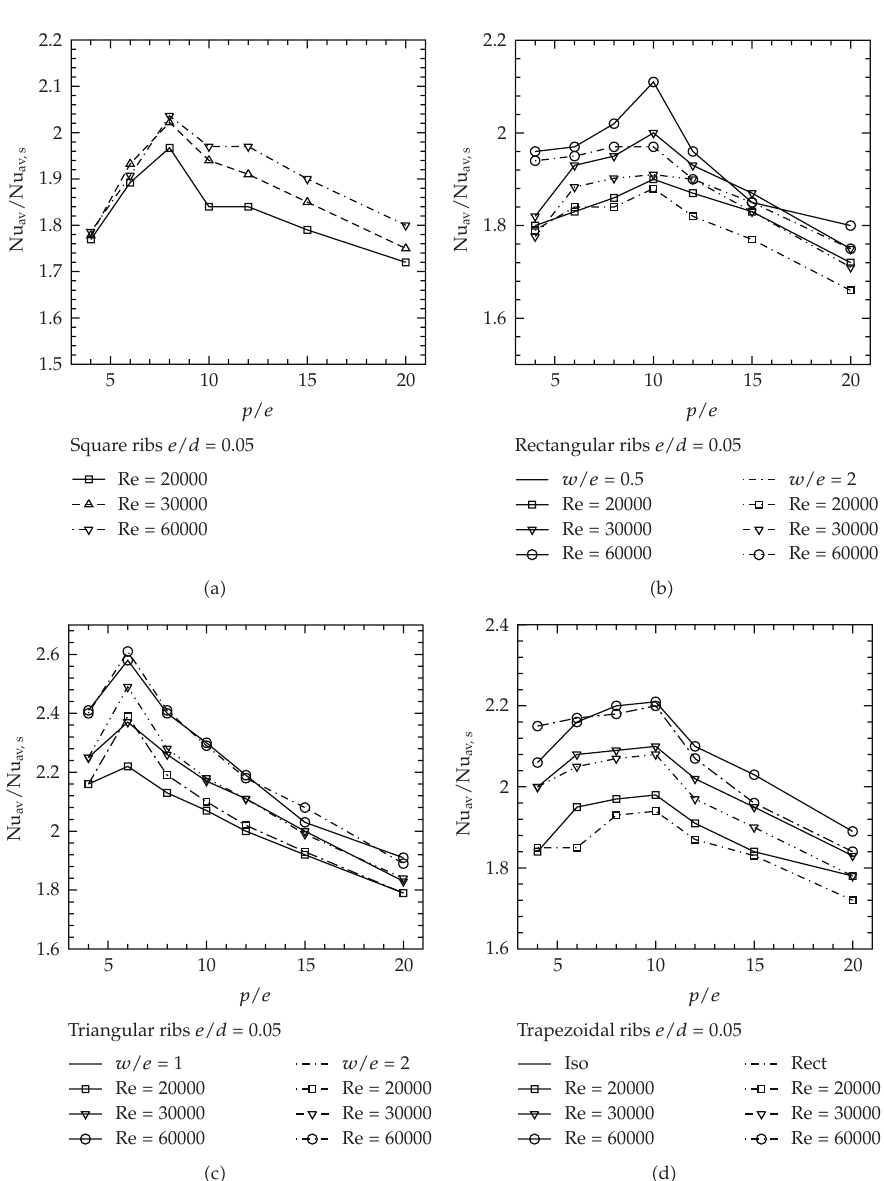
Figure 4: Average Nusselt number profiles, referred to the smooth channel results, as a function of p/e at Re (cid:8) 20000, 30000, and 60000, for e/d (cid:8) 0 . 05: (cid:6) a (cid:7) square-ribs, (cid:6) b (cid:7) rectangular ribs with w/e (cid:8) 0 . 5 and 2.0, (cid:6) c (cid:7) triangular ribs with w/e (cid:8) 1 . 0 and 2.0, and (cid:6) d (cid:7) isosceles and rectangular trapezoidal ribs with w/e (cid:8) 2 .